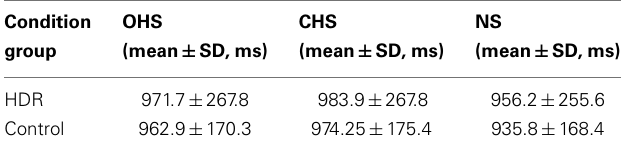
Table 6 | Mean and SD of each sentence list in HDR